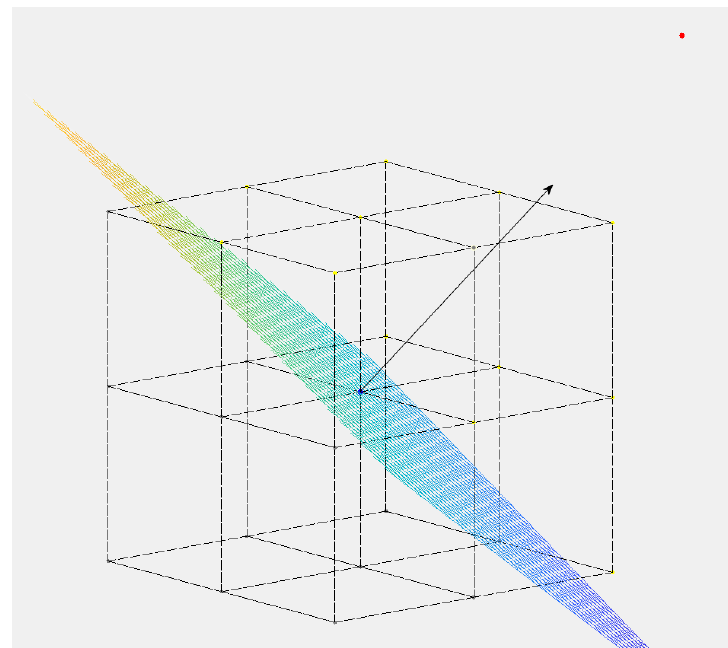
Figure 6. Node filtering conditions.